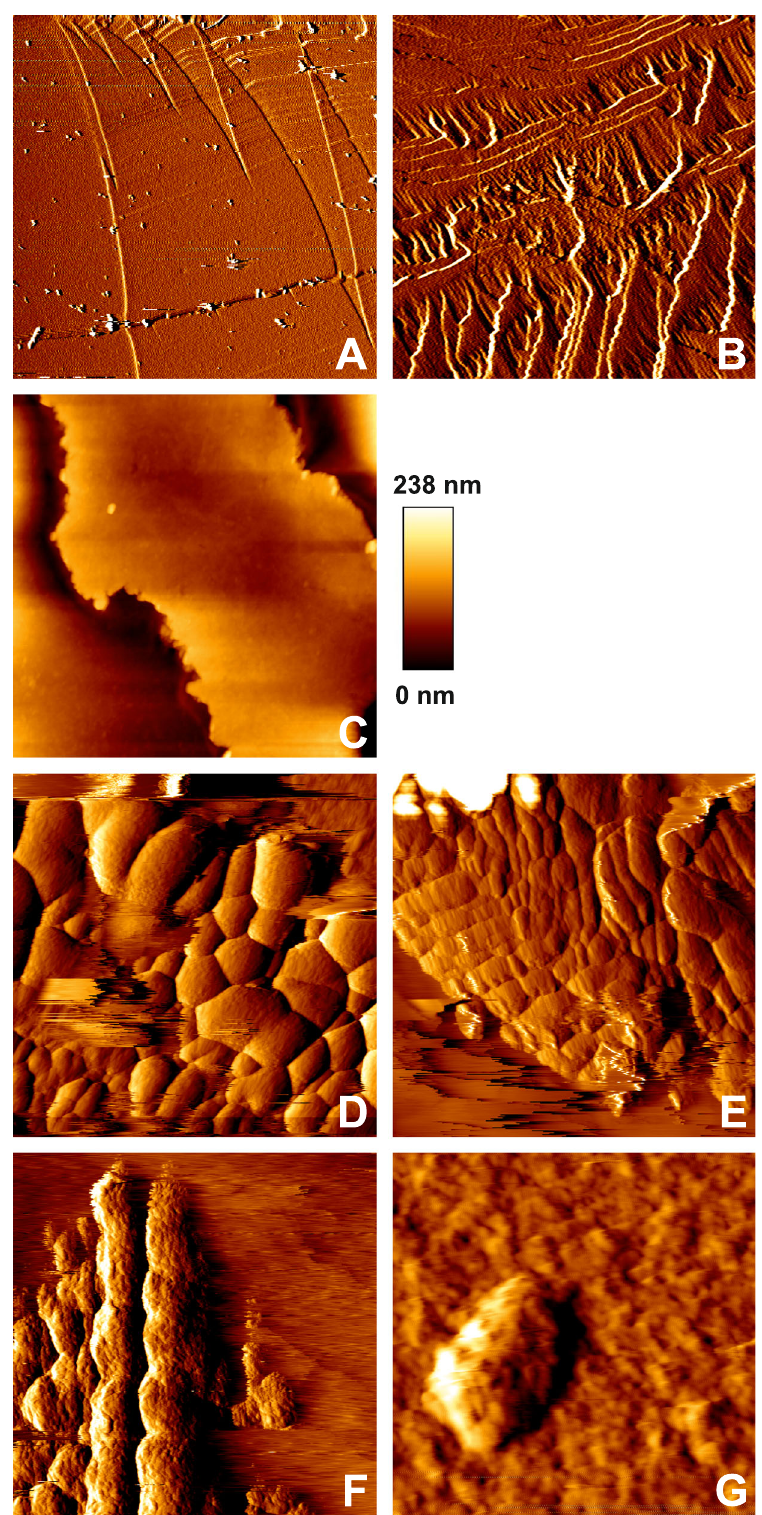
Fig. 4 Atomic Force Microscopy (AFM) images of diopside. A – C In situ AFM images of diopside surfaces immersed within sterile electrolyte media for up to 5 h ( A 70 × 70 μm², de fl ection mode; B 20 × 20 μm², de fl ection mode; C 12 × 12 μm², height mode — with the color scale spanning a total of 238 nm). D – G In situ AFM images of diopside surfaces immersed in nutrient media ( D 8.6 × 8.6 μm², de fl ection mode; E 10 × 10 μm², de fl ection mode; F 5.5 ×5.5 μm², de fl ection mode; G 1.5 × 1.5 μm², de fl ection